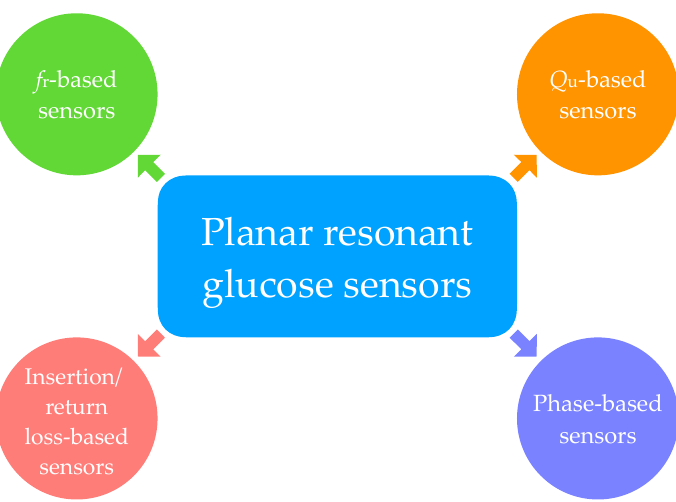
Figure 2. Proposed sensing parameter-based classification scheme.